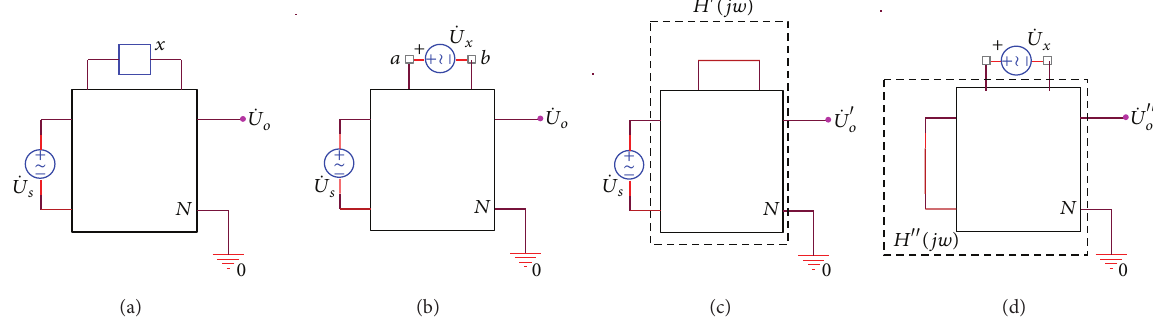
Figure 2: (a) Nominal network, (b) equivalent network, (c) 𝑁 stimulated by 𝑈 𝑠 , (d) 𝑁 stimulated by 𝑈 𝑥